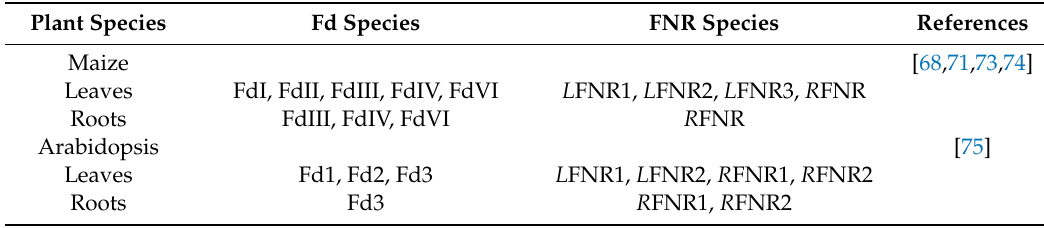
Table 4. Representative iso-proteins of Fd and FNR identified in the leaves and roots of maize and